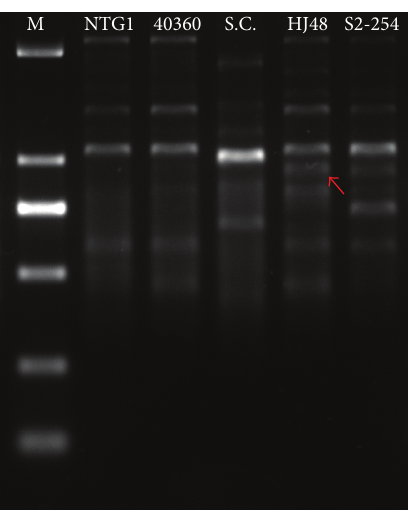
Figure 2: Genetic variation of fungus by Random Amplified Poly- morphic DNA (RAPD) analysis. (Lane 1: marker; Lane 2; mutant NTG1; Lane 3: T. reesei CICC 40360S2-254; Lane 4: S. cerevisiae 31279; Lane 5; HJ48; Lane 6: S2-254.).